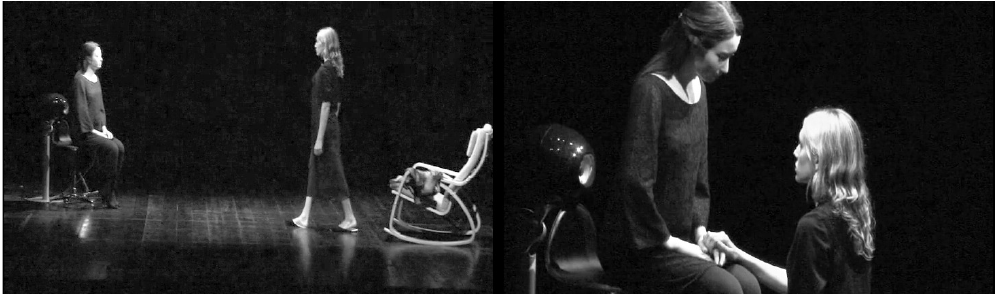
Figure 4. One scene of “Sayonara”; The actress silently comes close to the Android (left), and the Android looks at the actress’s face (right). Then, the Android looks away and recites the